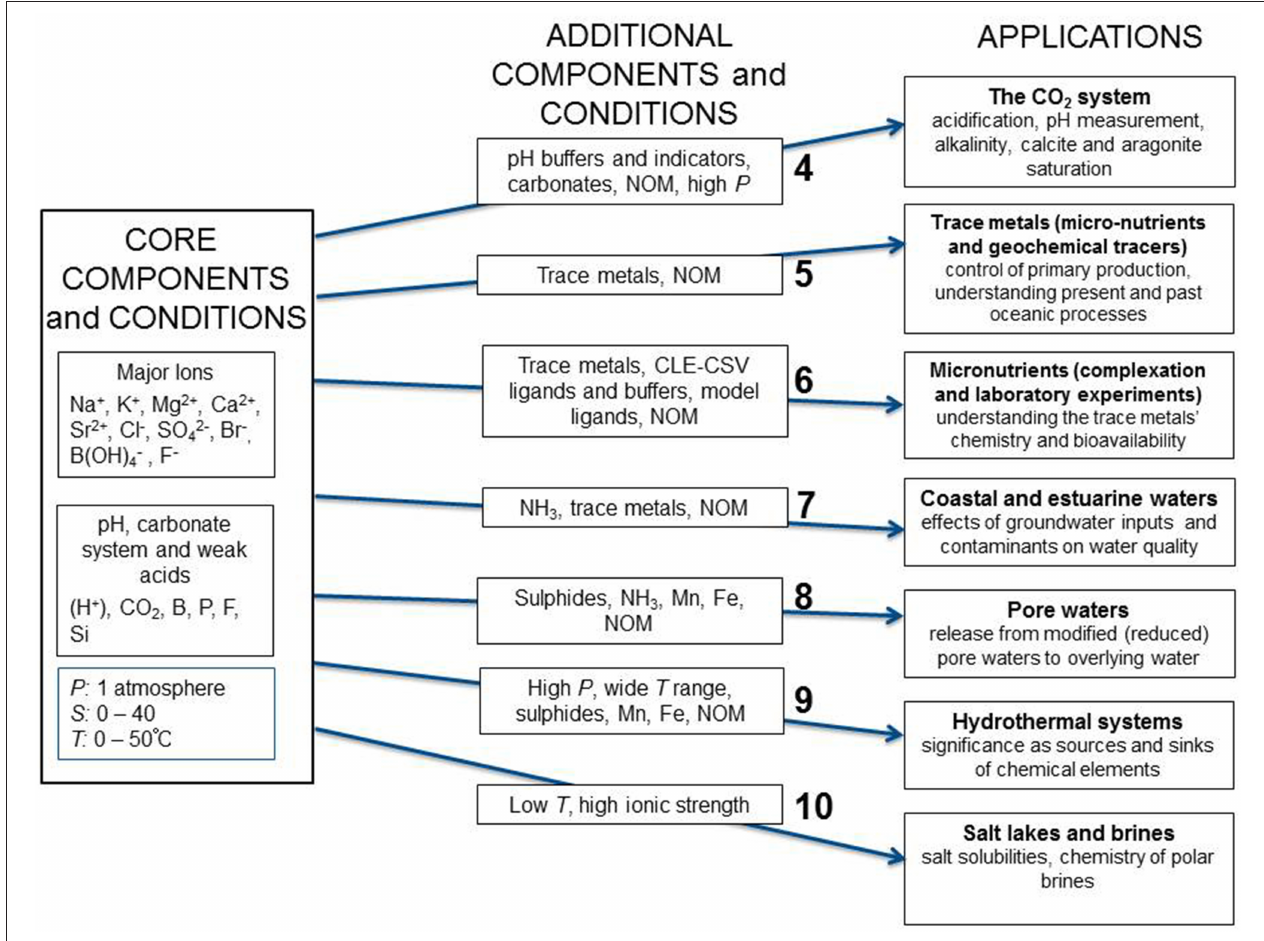
FIGURE 1 | Schematic diagram showing the core components and conditions, and seven groups of additional components and conditions with associated applications for the Pitzer chemical speciation model proposed by the SCOR WG 145. These conditions and applications cover the majority of problems biogeochemists face in describing the chemical speciation of elements in marine and estuarine environments. Each set of additional components, conditions and applications is discussed in the text section indicated by the number shown in the